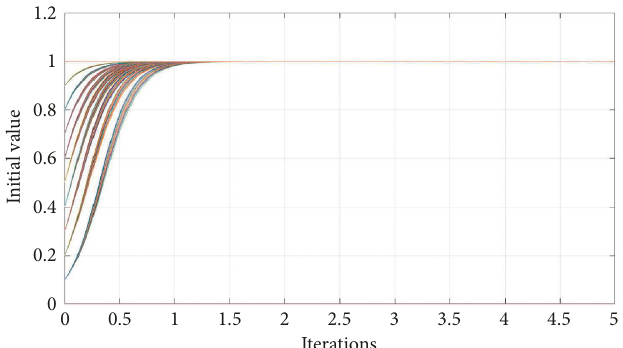
Figure 7: dx / dt − t in hypothesis 2 value under different initial values.